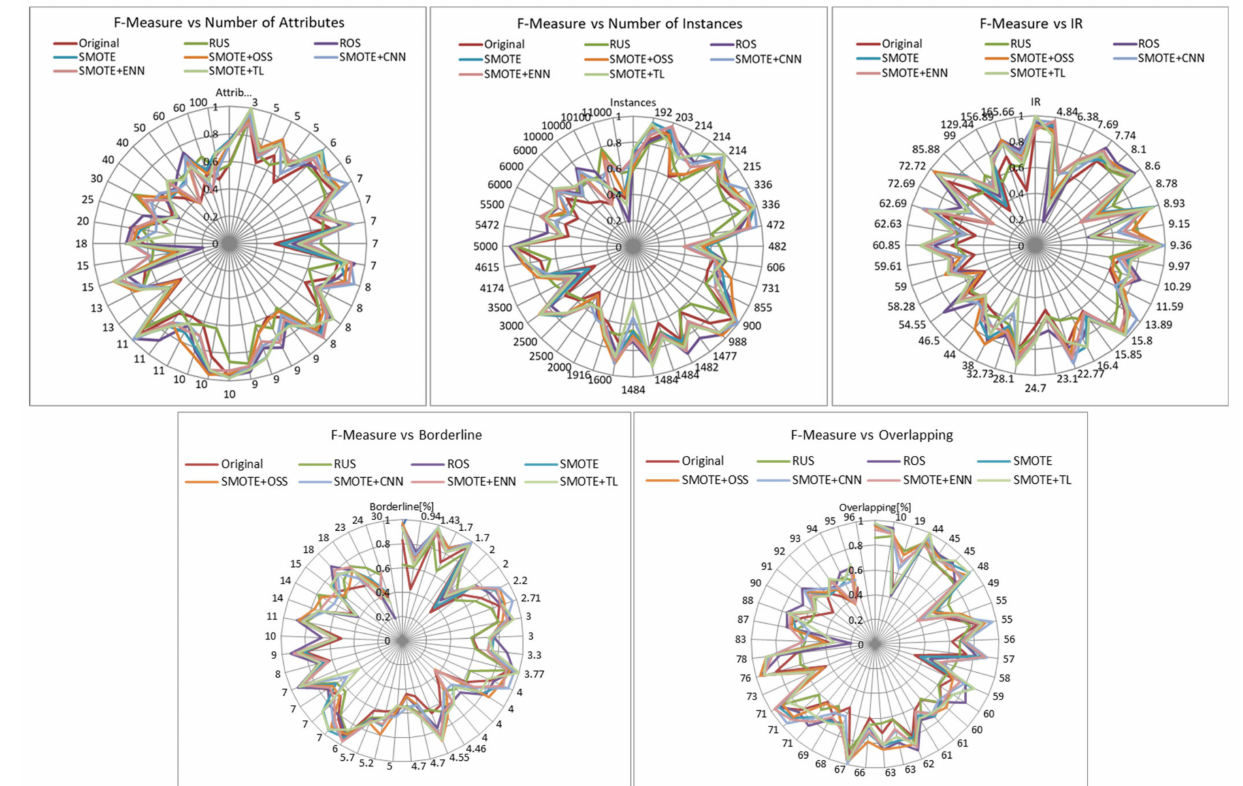
Figure 5. Influence of dataset characteristics on F-measure for all resampling strategies.